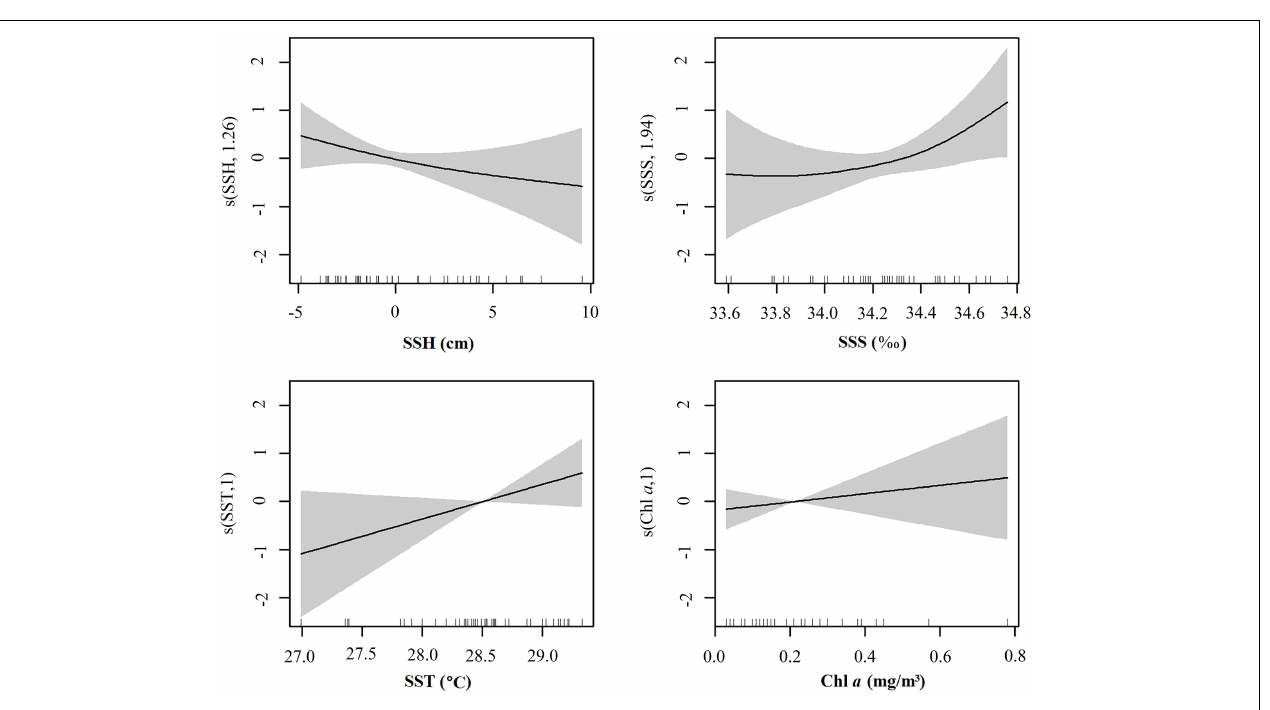
FIGURE 4 | Non-linear responses of ichthyoplankton abundance to environmental